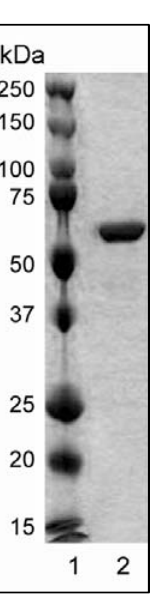
Figure 1. SDS-PAGE profile of recombinant wild-type rHvExoI (lane 2) used for crystallisation by self-nucleation and macro- and cross-seeding using hanging-drop and sitting-drop vapour-diffusion methods. The rHvExoI protein (25 µg) was visualised with a Coomassie Brilliant Blue stain. Protein standards (5 µL of the Precision Plus Protein Standards’ stock) are indicated in lane